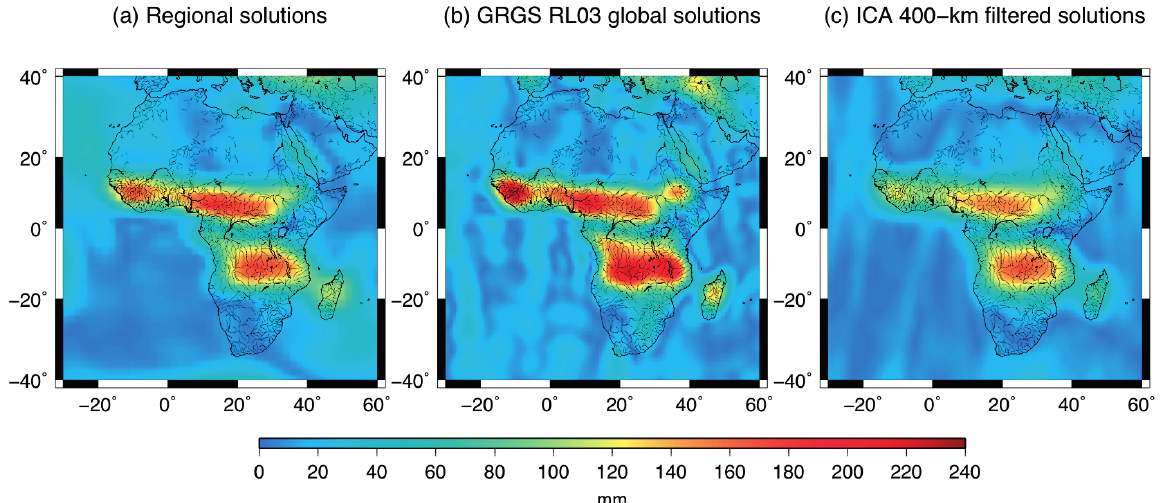
Figure 5. Maps of the seasonal amplitudes of the water mass changes adjusted by least squares adjustment of a pure annual sinusoid at each grid cell of the 10-day regional solutions over Africa (2003–2012): ( a ) Regional solutions; ( b ) GRGS RL03 global solutions; ( c ) ICA 400-km filtered solutions. Units are mm of EWH. Note the strong signals due to the African monsoon in the Sahel latitudinal band.